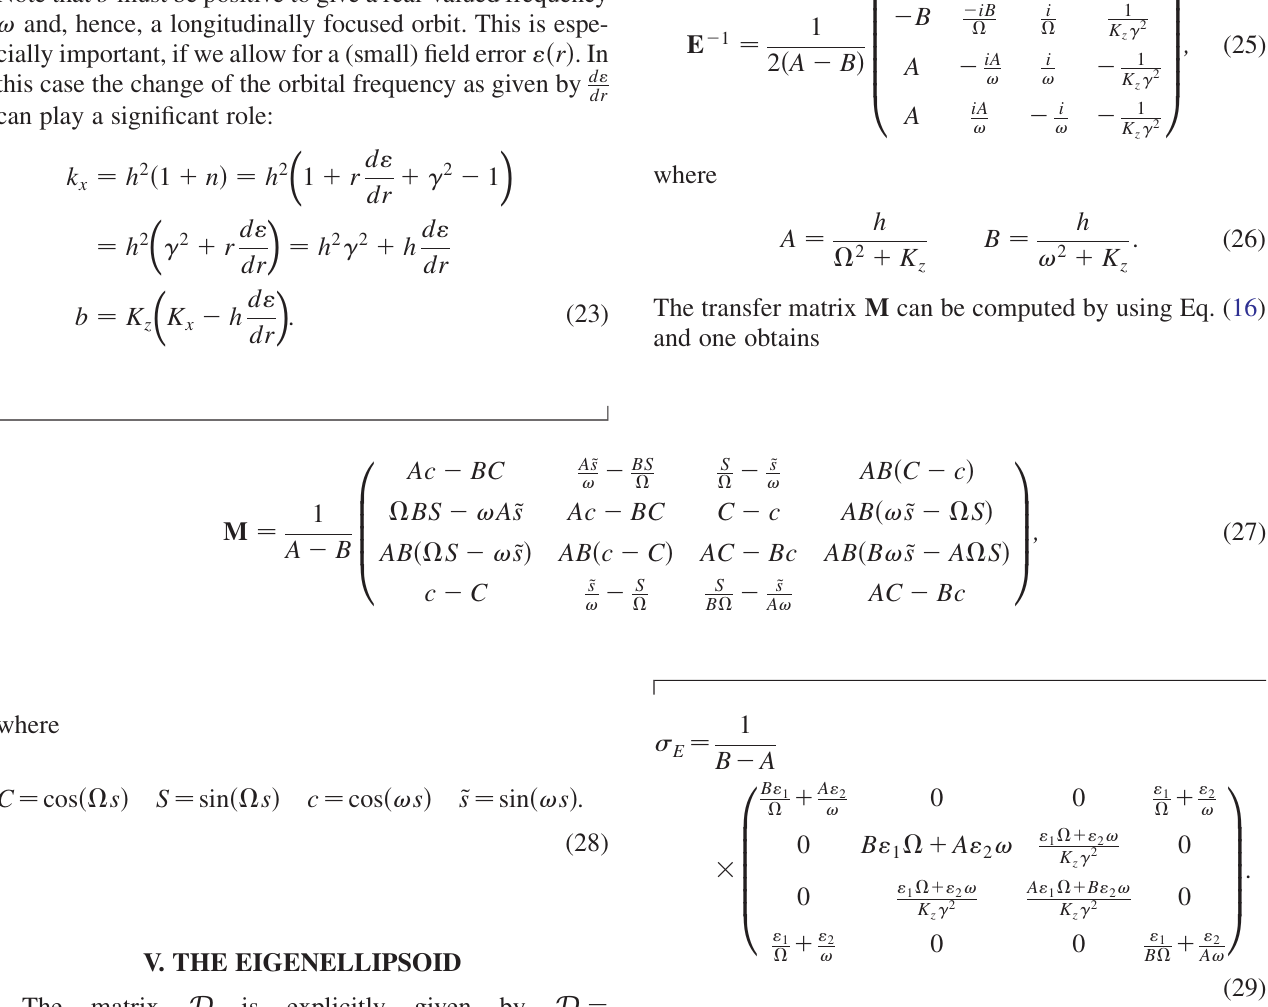
ffiffiffiffiffiffiffiffiffiffiffiffiffiffiffiffiffiffiffiffiffiffiffiffiffiffiffi